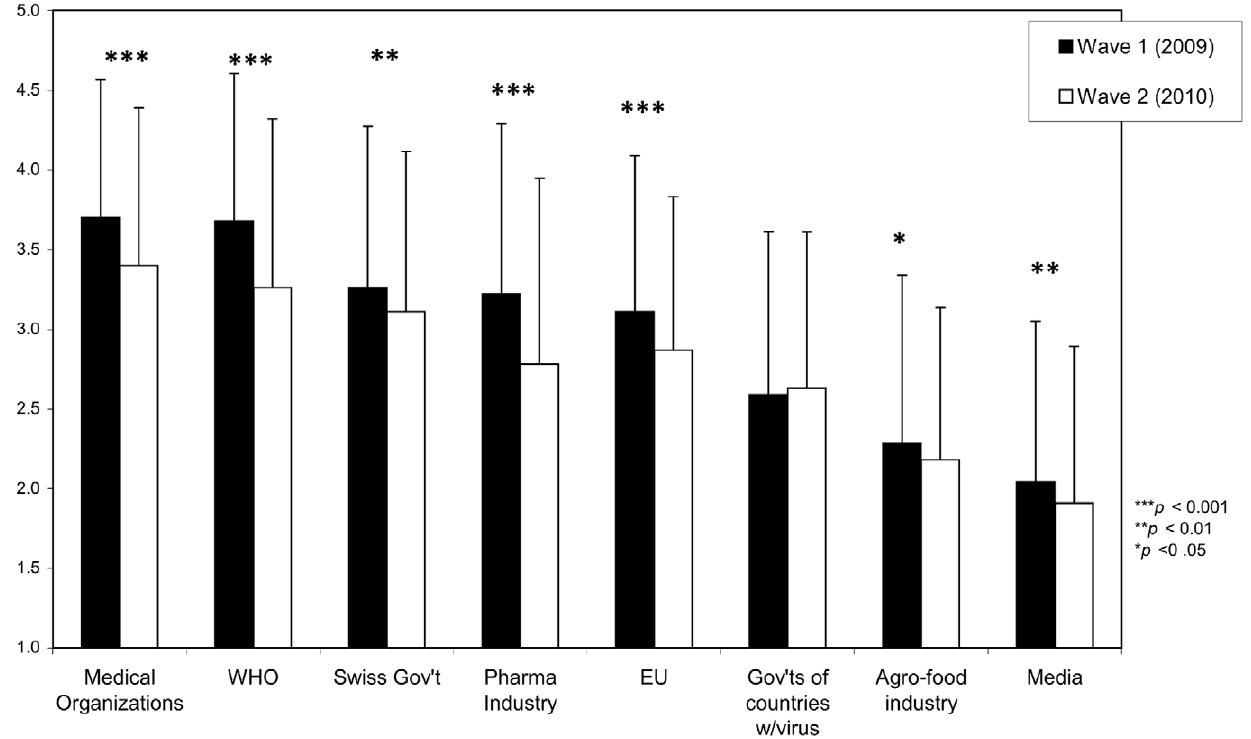
Figure 2. Trust in Institutions, Waves 1 and 2 (error bars indicate one standard deviation). doi:10.1371/journal.pone.0049806.g002 PLOS ONE |